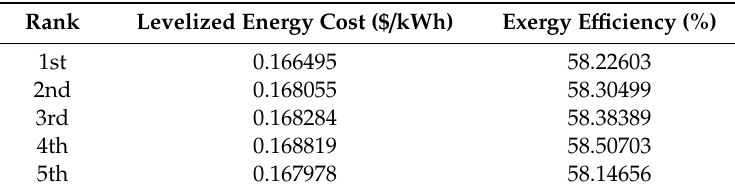
Table 6. The five best solutions proposed by technique for the order of preference by similarity to